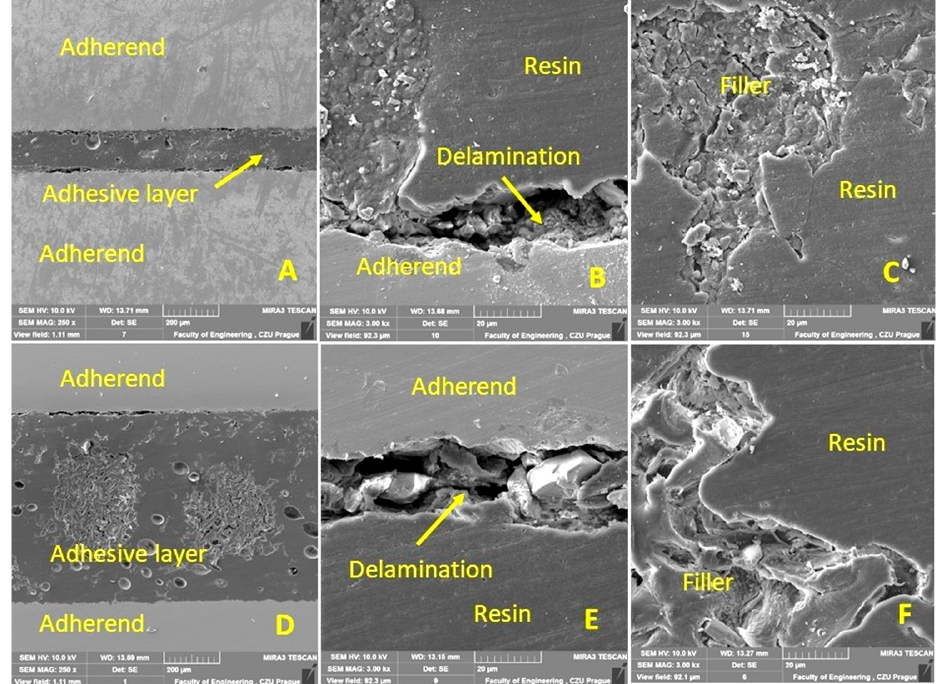
Figure 11. SEM analysis of a cross-section of a hybrid adhesive layer with C-filler (SE detector Oxford): ( A ): Cross-section of a hybrid adhesive bond with C-filler (MAG 250×), ( B ): Interaction between hybrid adhesive layer and adherend (MAG 3000×), ( C ): Interaction between C-filler and resin (MAG 3000×), ( D ): Cross-section of hybrid adhesive bond with filler C_NaOH (MAG 250×), ( E ): Interaction between hybrid adhesive layer and adherend (MAG 3000×), ( F ): Interaction between filler C_NaOH and resin (MAG 3000×).